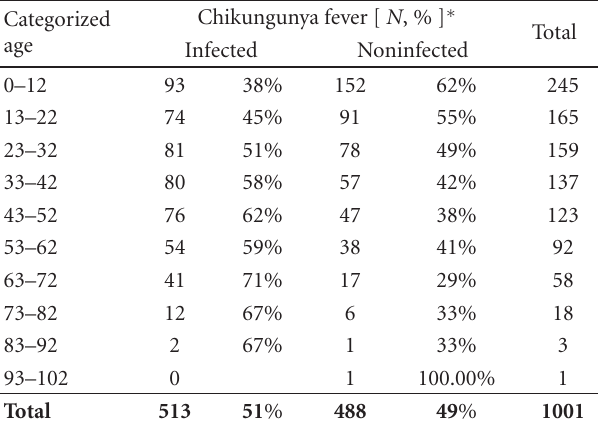
Table 2: Incidence of chikungunya infection by age